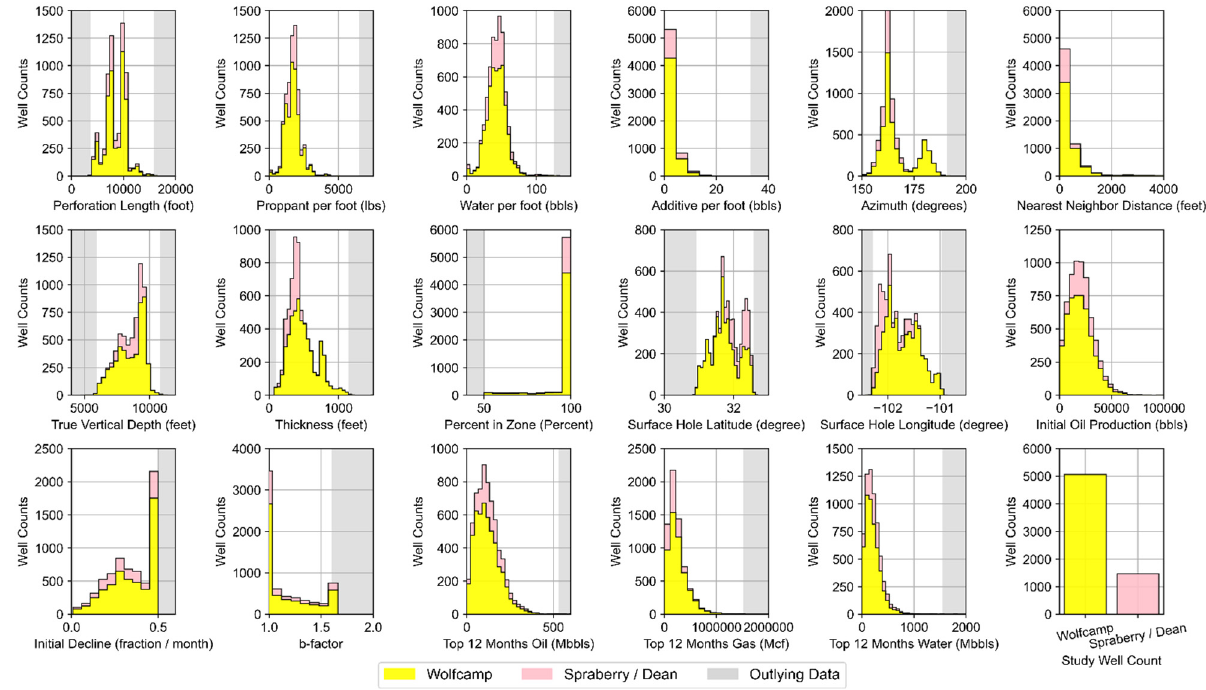
Figure 3. Distribution of static features for each well in the study dataset. Table 2. Statistical summary of the study dataset features evaluated.